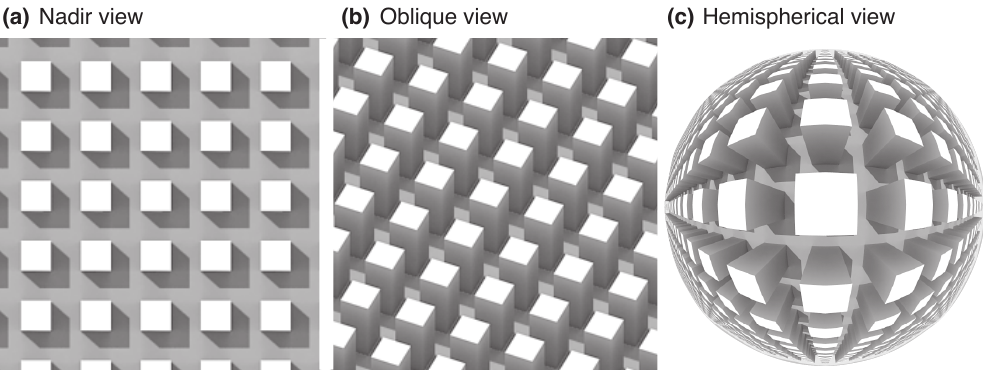
Figure 1. Projected field of views (FOV) for various sensor view geometries on a generic array composed of aligned blocks of width H , height 2 H and an inter-element spacing H . The figure shows (a) a sensor with a narrow FOV in the nadir, (b) a sensor with a narrow FOV from an oblique view point and (c) a hemispherical radiometer facing